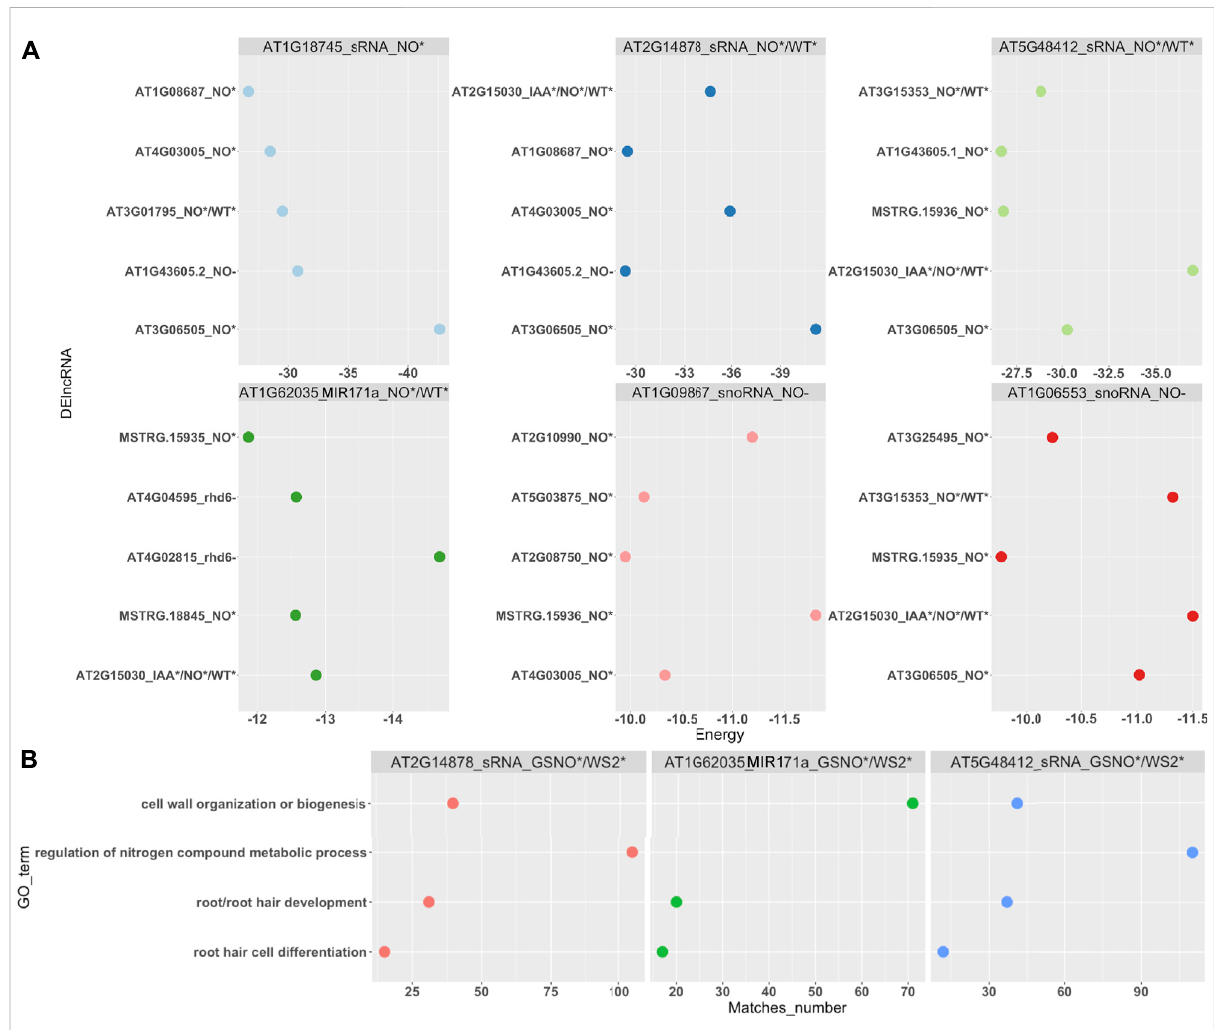
Small RNA (sRNA) interaction with DElncRNAs and DE PCG. As sRNA, we consider sRNA (could not have their types identi fi ed by annotation), nucleolar RNA(snoRNA),and microRNA (miRNA). (A) Topsix DElncRNA – sRNA pairs with thestrongestinteraction energy (negative values). Threeof them are differentially expressed in GSNO-treated and WS-2 individuals, potentially acting in the WS-2 root hair formation WS-2 phenotype. The x -axis shows the interaction energy values, whereas the y -axis represents the DElncRNA genes and their differential expression condition. (B) sRNA and DE PCG interaction. Top three DE PCG with the greatest number of Gene Ontology (GO) biological process (BP) terms matches. The BPs are mostly related to nitrogen metabolism and cell wall organization and root development. The x -axis represents the BP matches number and the y -axis represents the most common BP terms identi fi